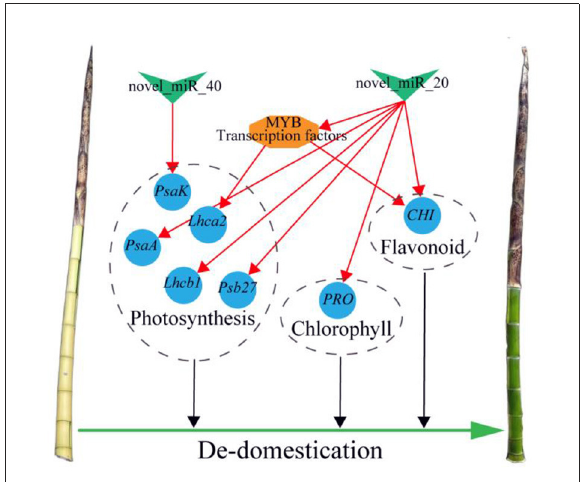
FIGURE10 Summary figure of the mechanism of de-domestication in regulating culm color of P . vivax cv. Green V-shape, blue circle, and orange hexagon respectively, indicate miRNAs, structural genes, and TF. The red lines indicate coherent miRNA-mRNA or TF-mRNA